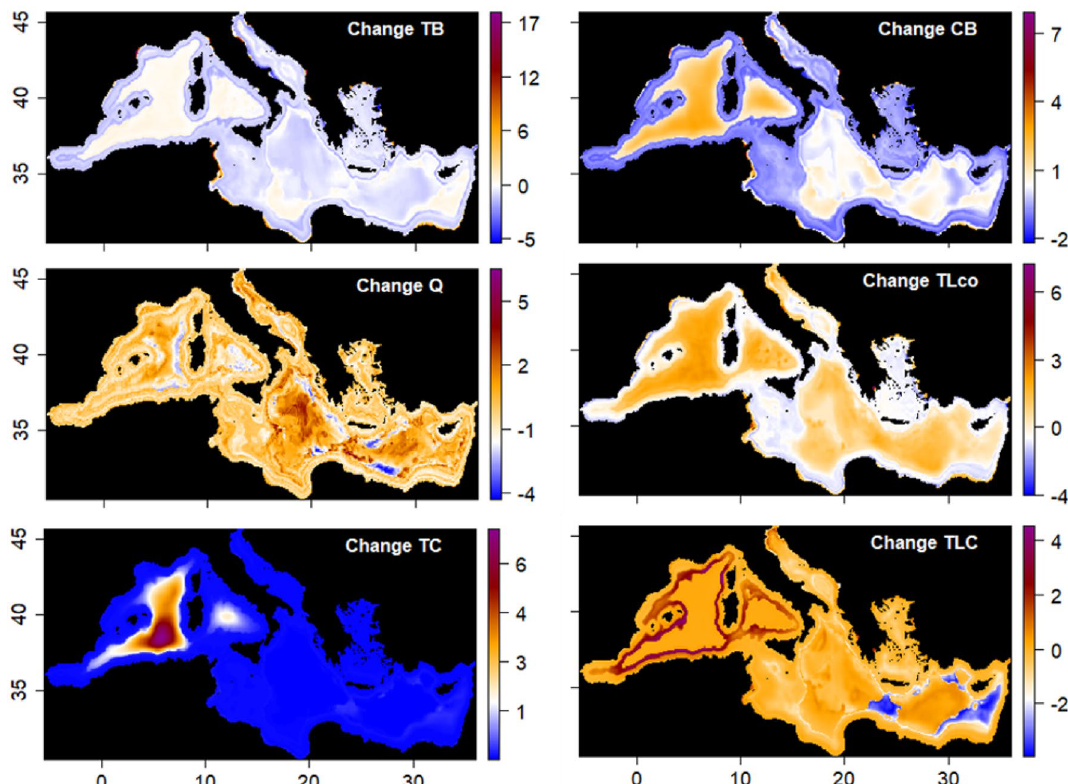
Figure 2. Mean (1995–2016) change (%) for selected modelled indicators. TB Total biomass, CB commercial biomass, Q Kempton index, TLco trophic level (TL) of species/Fg in the community, TC total catch, TLC trophic level (TL) of the catch. To facilitate the comparison, indicators were standardized (difference from the mean divided by the corresponding standard